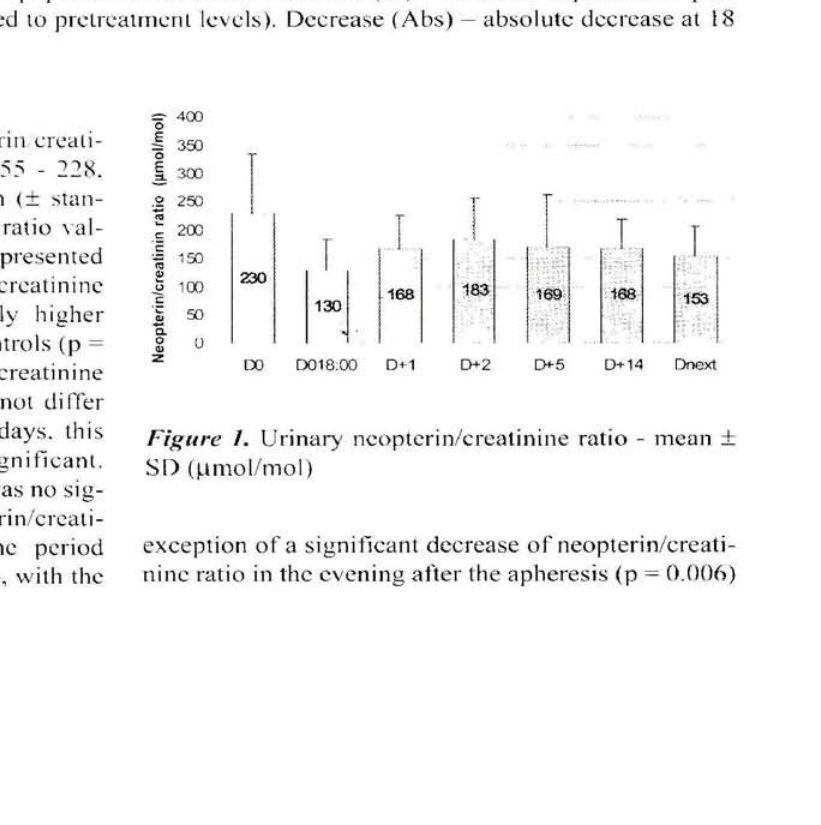
exception of a significant decrease of